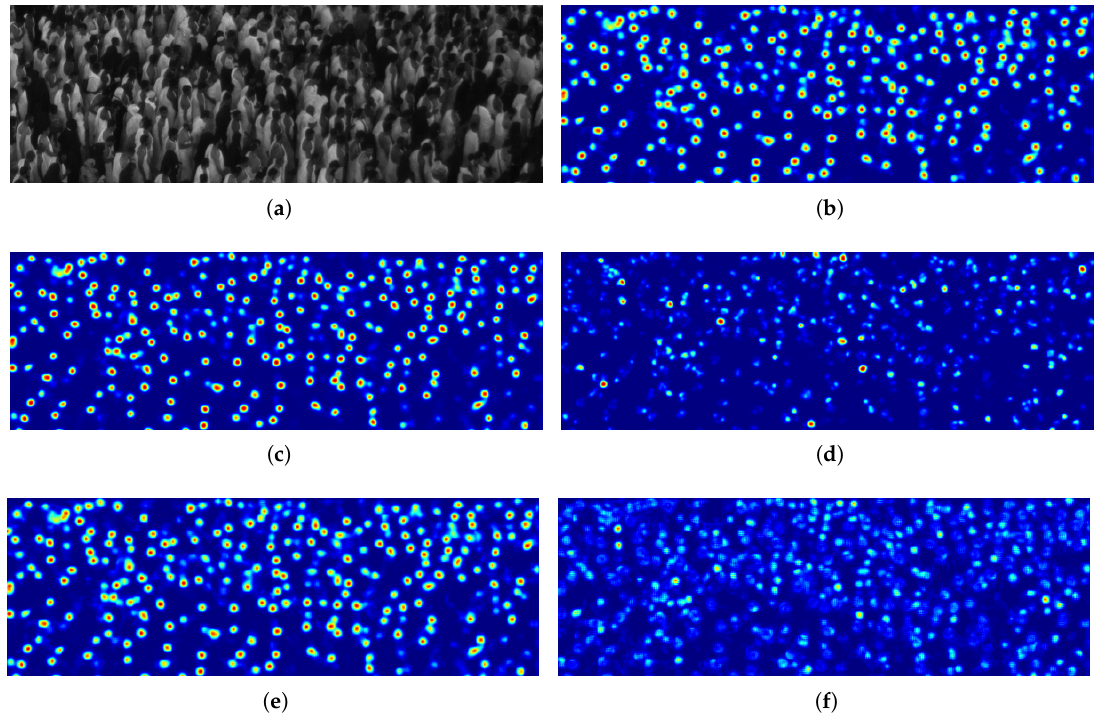
Figure 6. Output maps on a testing image patch with the deep learning solutions trained on the same amount of limited data, as well as model’s predictive uncertainty outputs through traditional standard deviation and proposed evidential ignorance. ( a ) Image patch; ( b ) Output map of FE + LFE; ( c ) Output map of CNN-ensemble Fusion, i.e., BetP ( H ) ; ( d ) Ignorance map of CNN-ensemble Fusion, i.e., M ( Θ ) ;